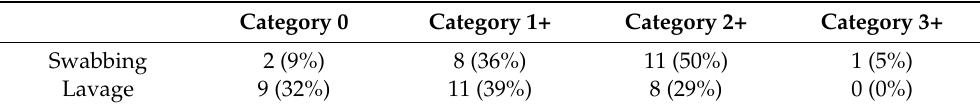
Table 7. Total numbers of cases and percentages per category for polymorphonuclear neutrophils (PMN) using each method. Category 0 corresponds to the absence of polymorphonuclear